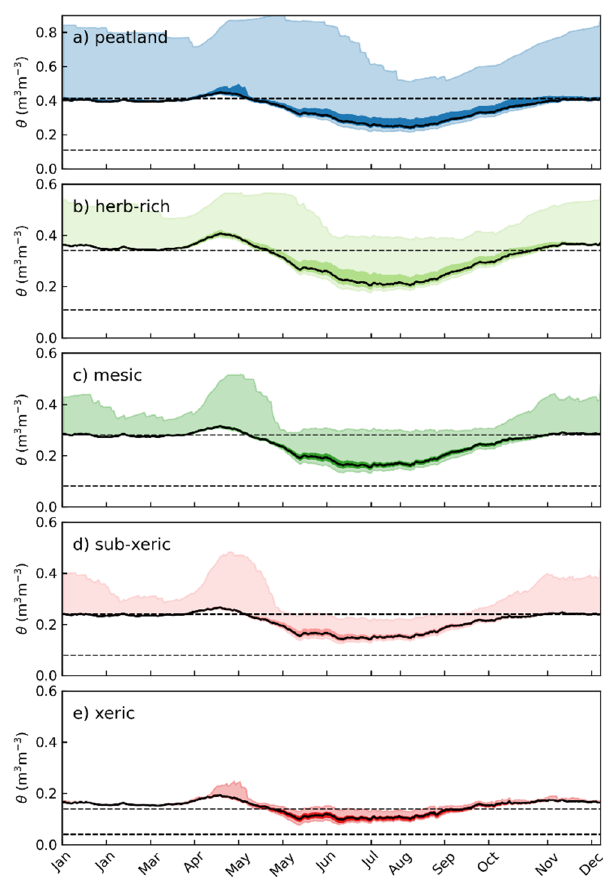
Figure 7. Seasonal variability of soil moisture ( θ ) at Paunulanpuro catchment in Southern Finland across grid cells at different site types. The figure was drawn by first computing mean soil daily moisture at each grid cell over the 2000–2015 period and then computing the PDFs over the grid cells belonging to each site type. The black lines show median, the dark shade the IQR (25th/75th) and light shade the 2.5th/97.5th percentiles. The site type color is as in Figures 8c and 9. The dashed horizontal lines indicate field capacity and wilting point as well as their difference in plant available water (AWC, Table 2). Note the y-axis scale in ( a ) is different to other panels.